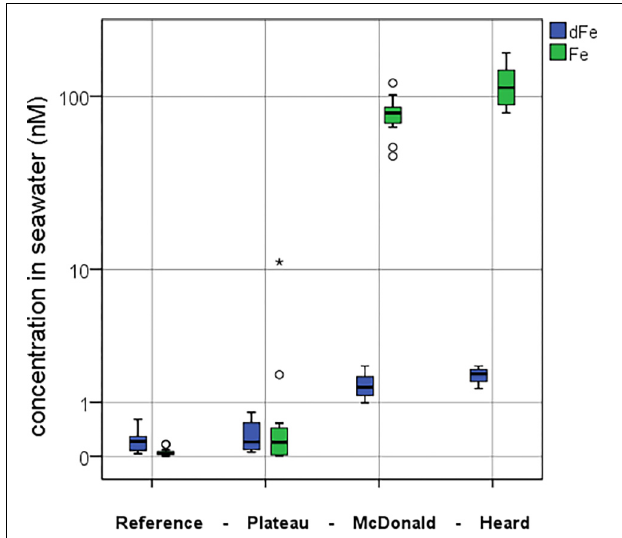
FIGURE 5 | Comparison between the mean dFe (blue) and mean pFe lab (green) concentrations at the four contrasting regions during the study. Full water column means are presented in nM. Standard boxplot median (centre black line), 25th and 75th percentiles (upper and lower box limits) and 95% confidence intervals (inner fences) are indicated. Outliers are shown as circles ( < 1.5 × the interquartile range) and asterisk ( > 1.5 × the interquartile range). The number of independent data points for the reference, plateau, McDonald and Heard regions were 15, 13, 12, and 9 for pFe lab and 16, 14, 12, and 9 for dFe,